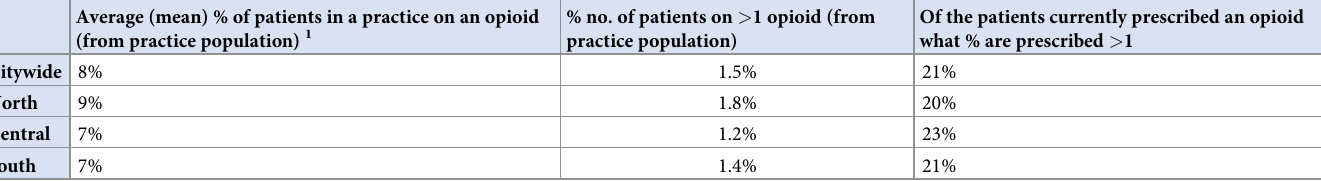
Table 5. Percentage of patients currently prescribed an opioid across localities during 2016–2018. Average (mean) % of patients in a practice on an opioid (from practice population) 1